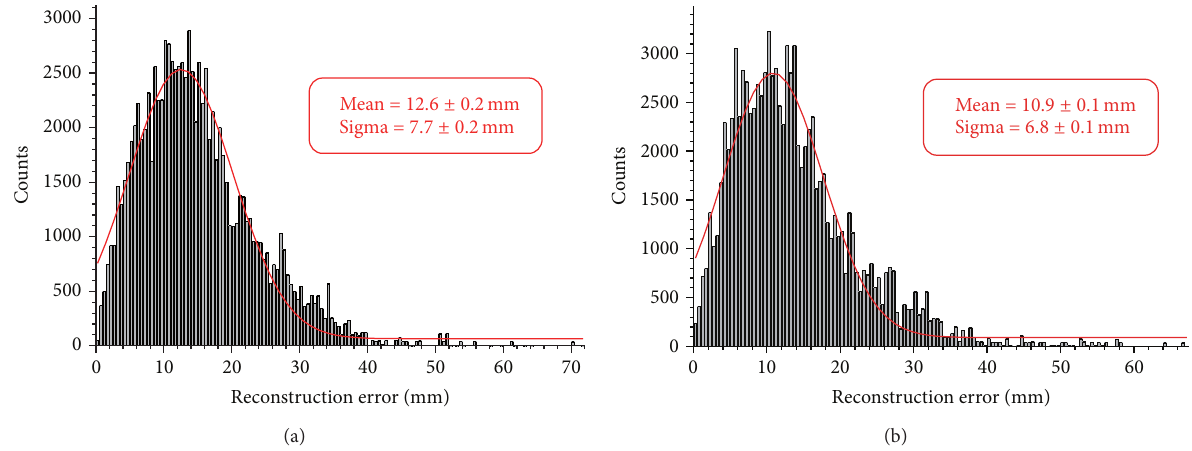
Figure 9: (a) Distribution of errors on reconstruction of the event position, for the sample of MC data, before corrections. (b) The same, after corrections. The error is the absolute difference between the real and reconstructed position.